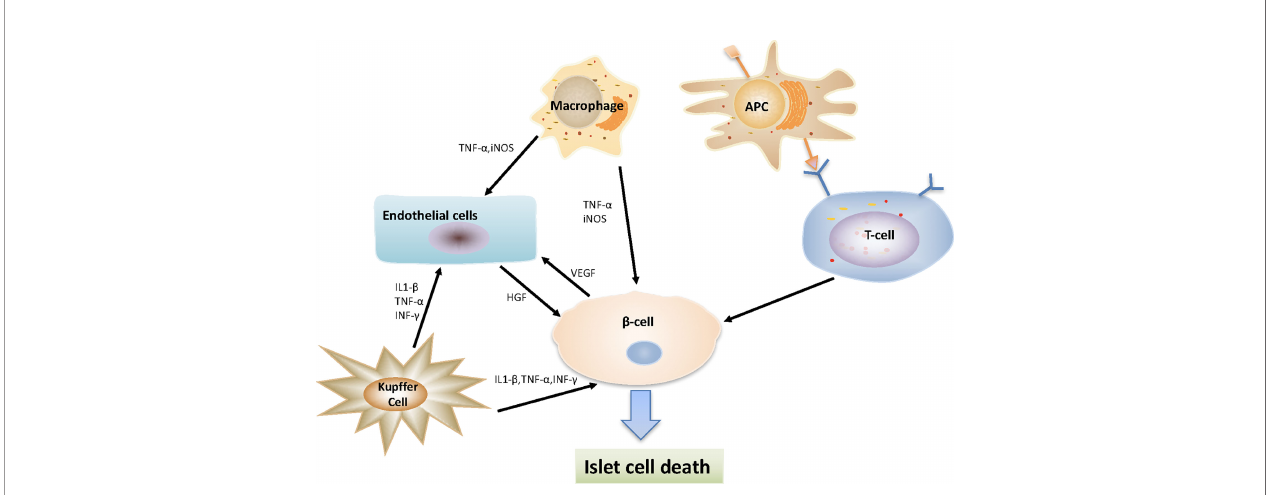
FIGURE 2 | Interaction between various types of cells after islet transplantation. Macrophages secreting TNF- a and iNOS, which act on beta-cells and endothelial cells to play a pro-in fl ammatory function; Kupffer cells secreting a series of substances (including IL-1 b , IFN- g and TNF- a ), directly affecting the survival of intrahepatic islets and endothelial cells; Antigen presenting cells (APCs) take and process antigens from donor and present antigens to host T cells, then reactive CD8+, CD4+ T-cells destroy transplanted islet b